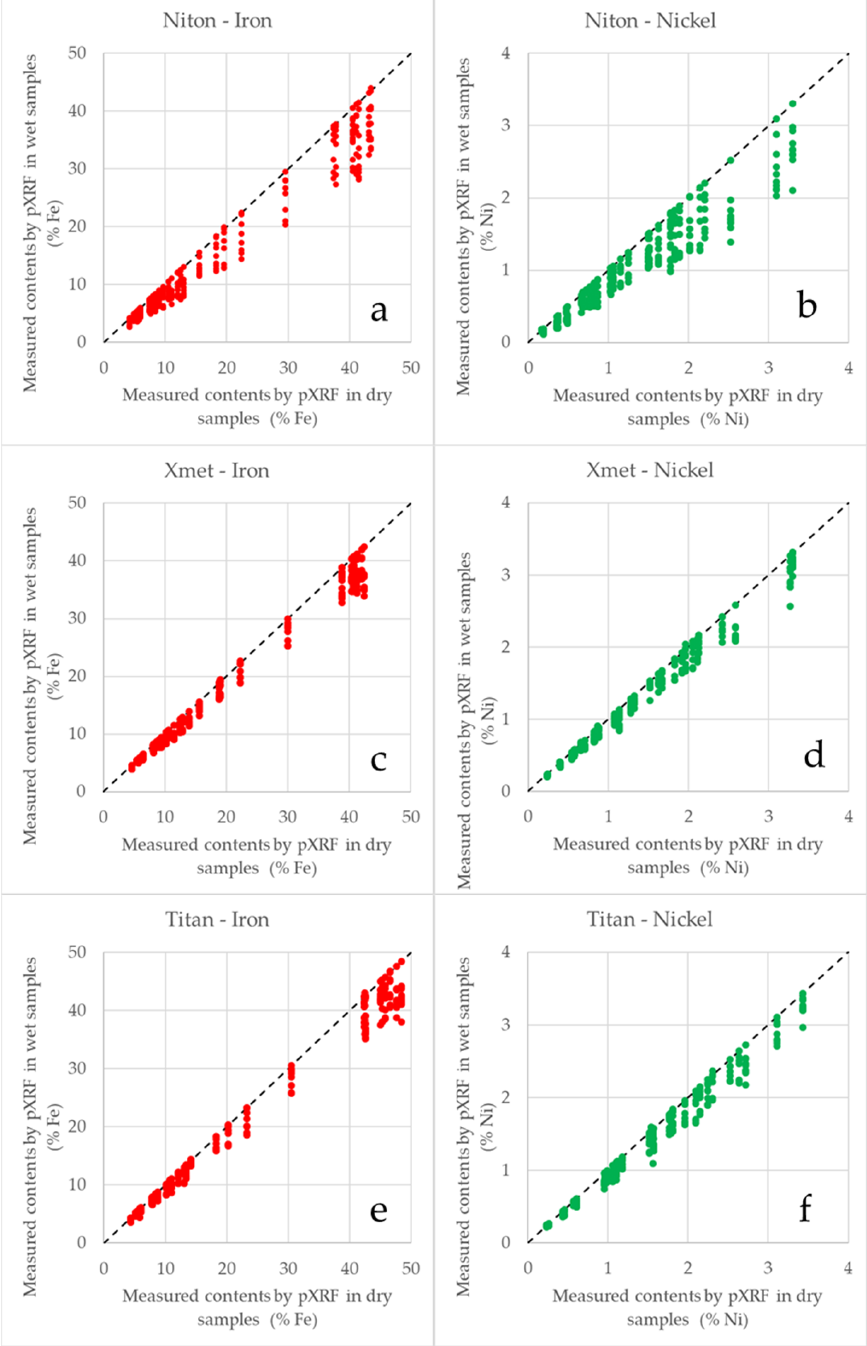
Figure 9. Influence of water content on Fe and Ni concentrations: ( a , b ) Niton, ( c , d ) Xmet and ( e , f ) Titan. The bisector is represented by the dashed line on the figures.